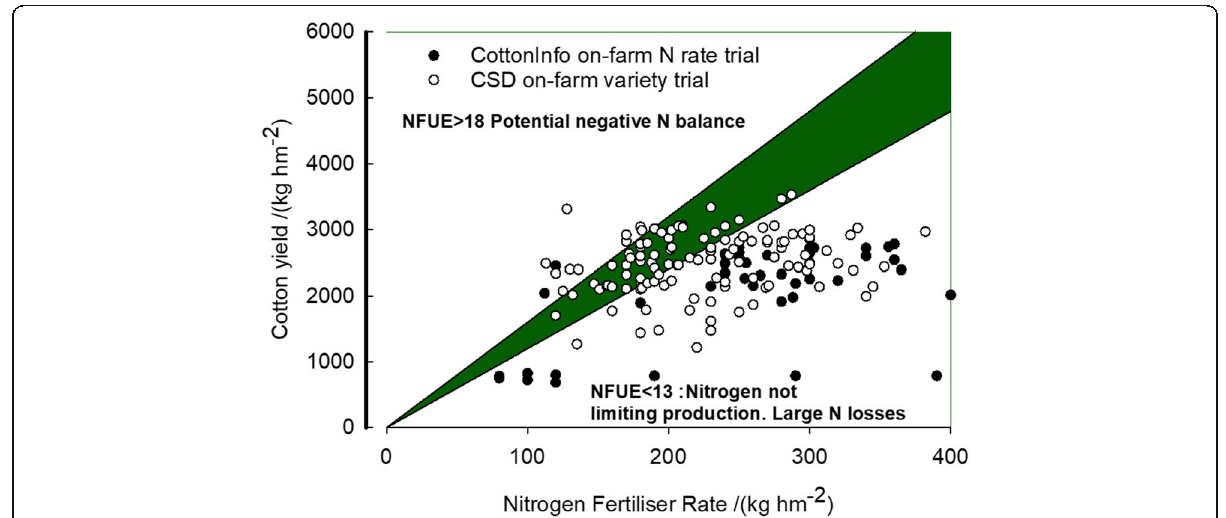
Fig. 4 NFUE of the 2008 – 2012 CottonInfo rate trials and the CSD farm variety trials (Anon 2013). Trial sites were located in all cotton production irrigation